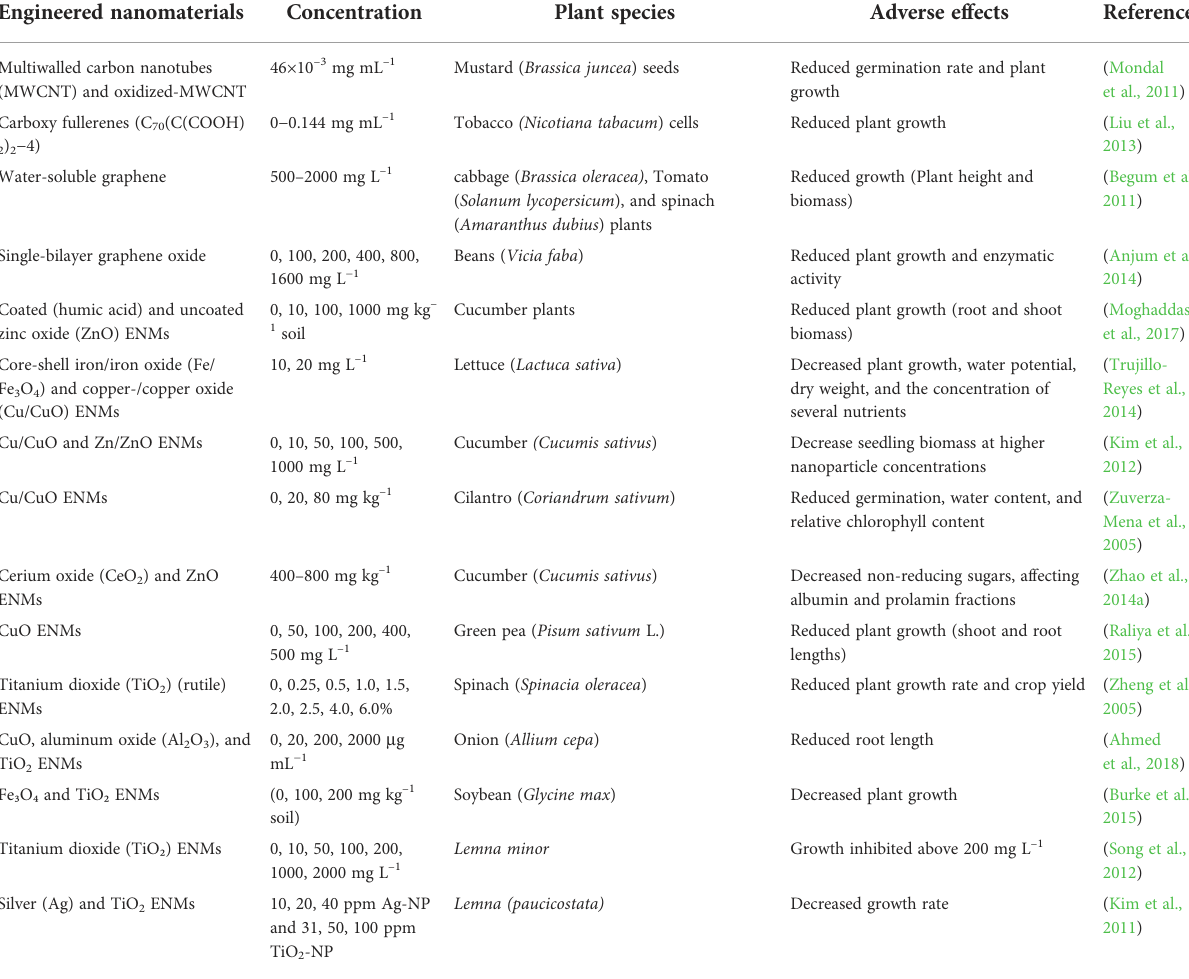
TABLE 6 Limitation and pitfalls of using engineered nanomaterials on plants. Engineered